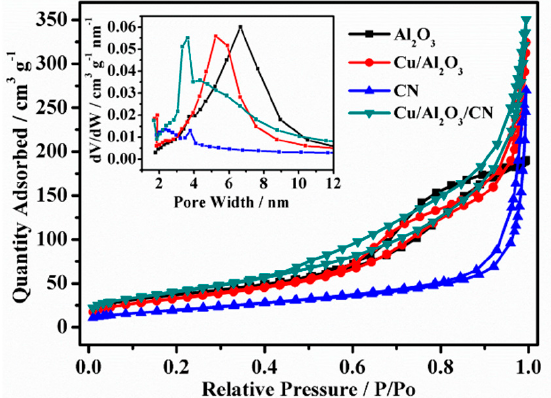
Figure 5. N 2 adsorption/desorption isotherm and the pore size distribution (insert) of the Al 2 O 3 , Cu/Al 2 O 3 , CN, and Cu/Al 2 O 3 /CN.